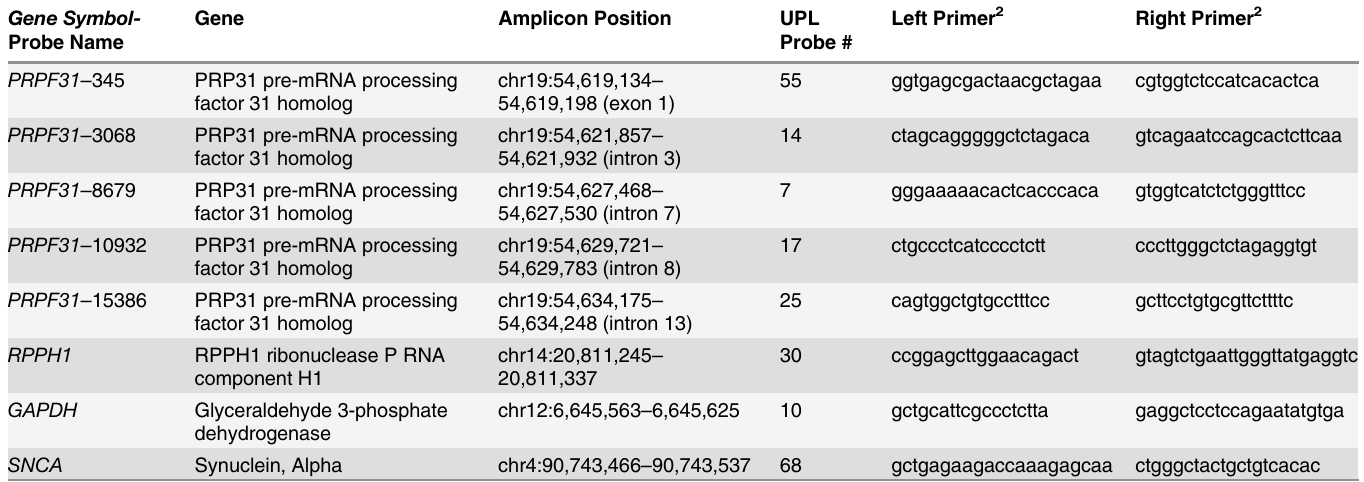
Table 1. UPL Probes used for validation of PRPF31 heterozygous deletion. The amplicon position is that reported by UCSC genome browser (hg19) in silico PCR tool. All primers are listed 5 ’ to 3 ’